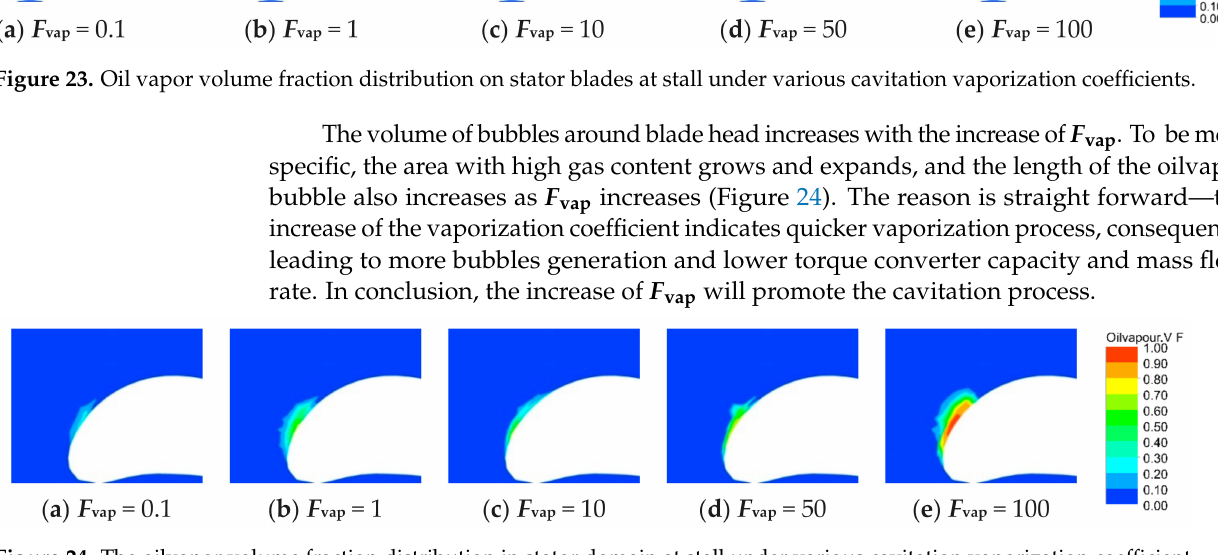
Figure 24. The oilvapor volume fraction distribution in stator domain at stall under various cavitation vaporization